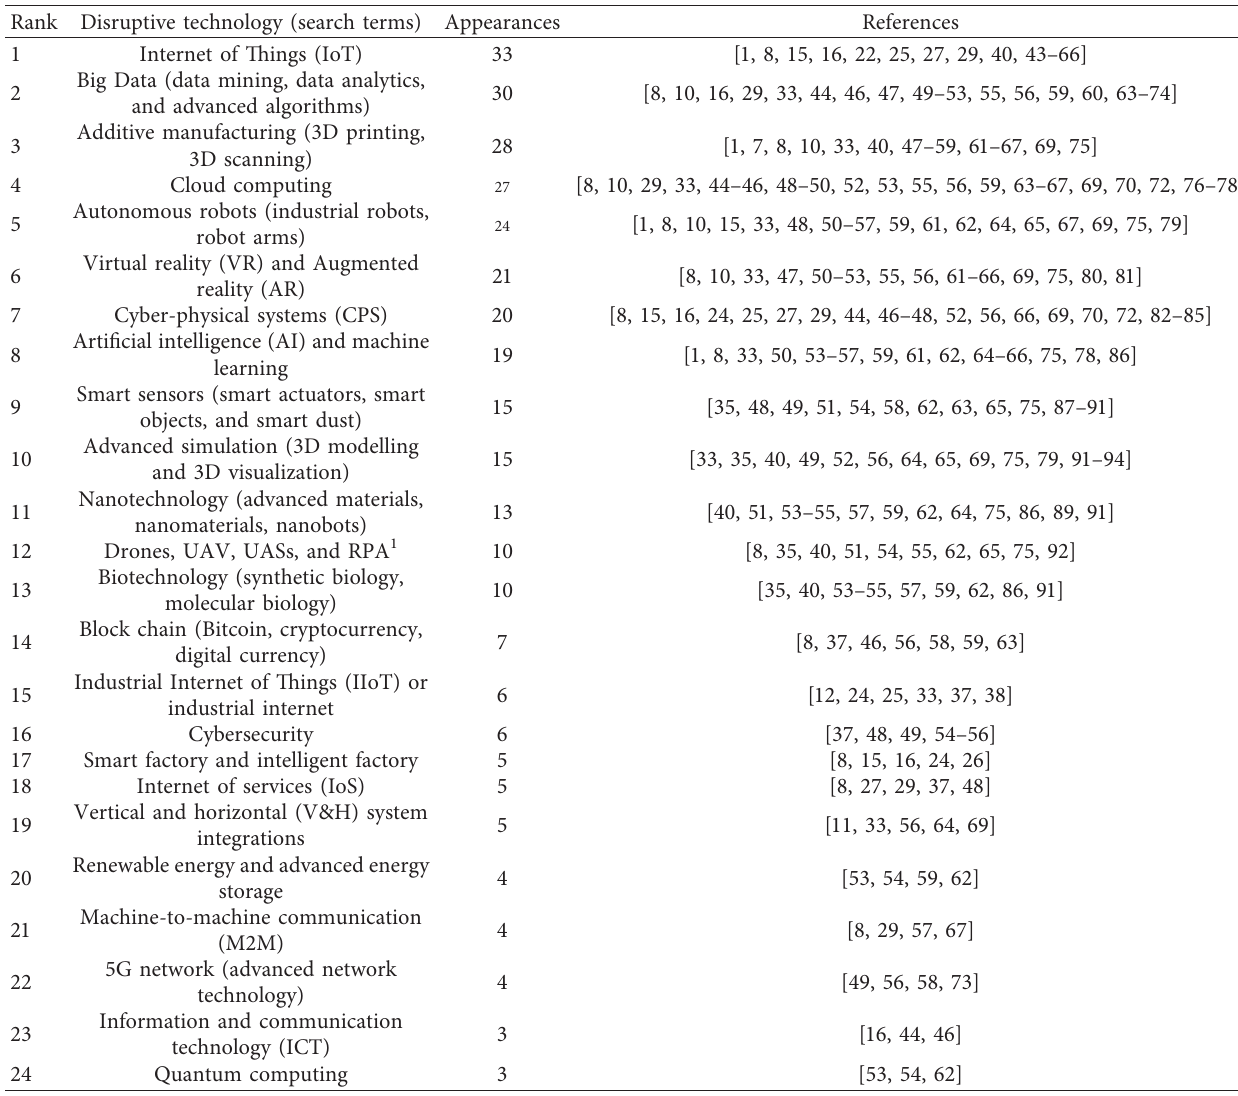
Table 2: Disruptive technologies of industry 4.0.